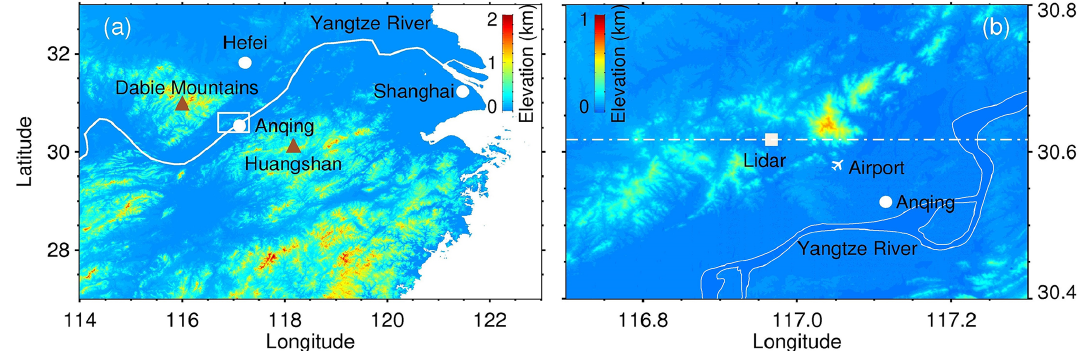
Figure 1. (a) Terrain elevation map. (b) Enlarged area over Anqing station in the hollow white rectangle in (a) . The computational domain is roughly along the white dash-dotted line in numerical simulations.